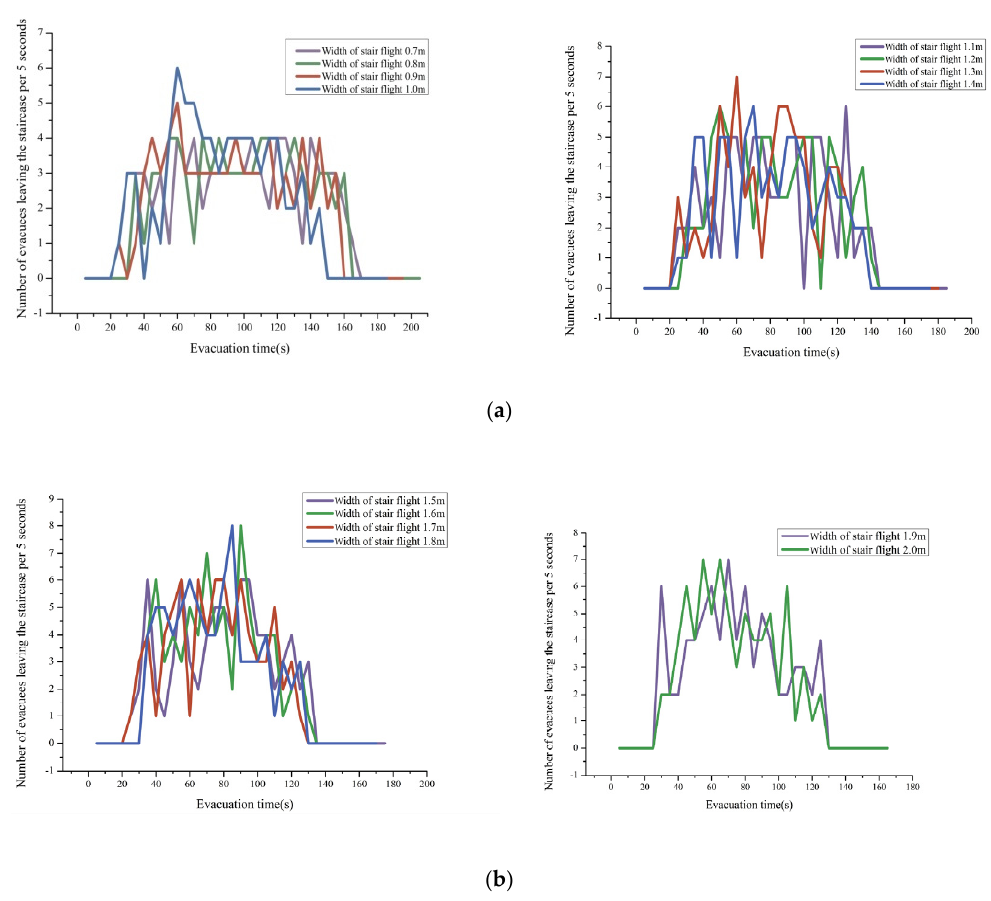
Figure 8. ( a ) Number of evacuees leaving the staircase per 5 s, Under the conditions of the stairs width of stair flight 0.7–1.0 m and 1.1–1.4 m; ( b ) number of evacuees leaving the staircase per 5 s, Under the conditions of the width of stair flight 1.5–1.8 m and 1.9–2.0 m.